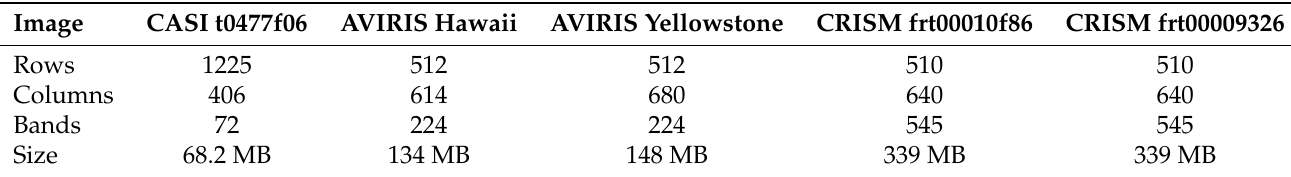
Table 2. Dimensions of the images used in this